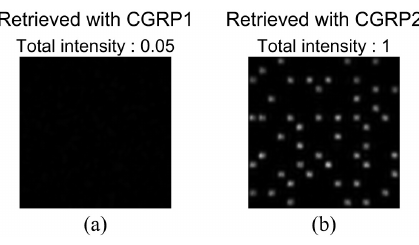
Figure 11. Intensity distributions of a reconstructed beam from a volume hologram of the data page 2 by illuminating with ( a ) CGRP1 and ( b ) CGRP2.